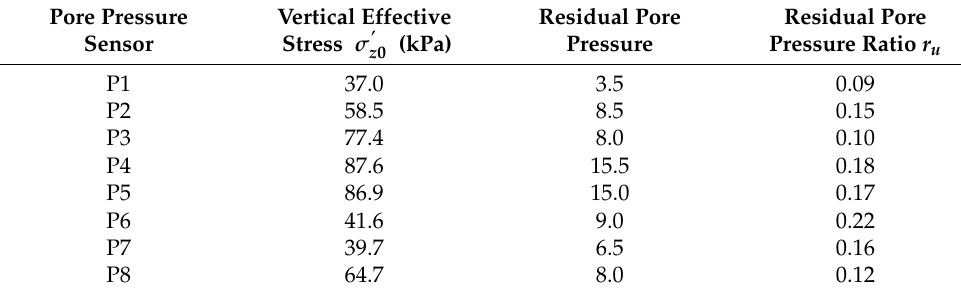
Table 3. Excess pore pressure ratio at P1 to P8 in Test 2.